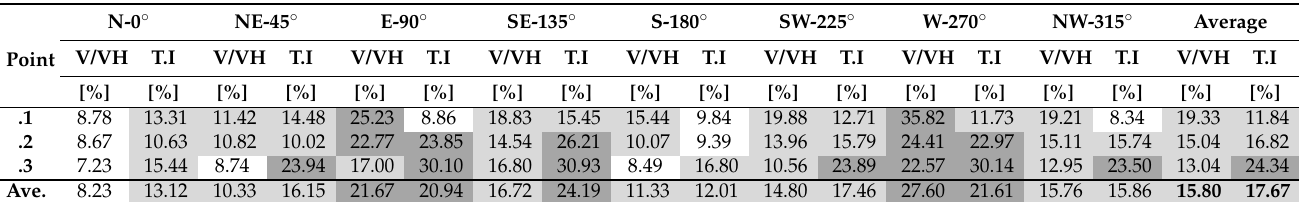
Table 8. Mean Absolute deviation results from Windsim per height and sector. V/VH is the ratio between velocity (V) and velocity at the top of the boundary layer achieved by the model (VH); TI is the turbulence intensity. Values shadowed by dark grey represent deviations with values ≥ 20% or ≤− 20% while values shadowed by light grey color represent deviation values ≥ 10% or ≤− 10% and no shadowed values have deviation values > − 10% or values < 10%. Points denoted by .1 or .2 or .3 mean height above ground at 9 m, 12 m, and 17 m,